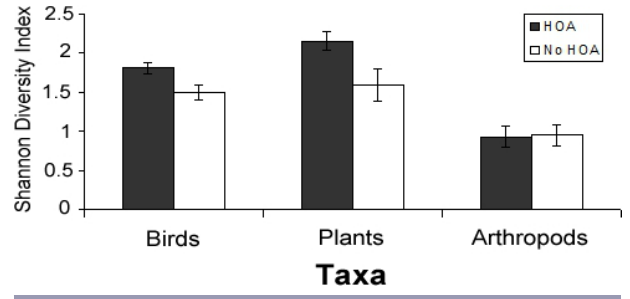
Fig. 3. Diversity relationships (bird, plant, and arthropod) between neighborhoods with a HOA and neighborhoods without a HOA in Phoenix, Arizona. Neighborhoods belonging to a HOA had greater native bird diversity and plant diversity compared with neighborhoods without a HOA. Arthropod diversity did not differ between neighborhood types. Standard error bars